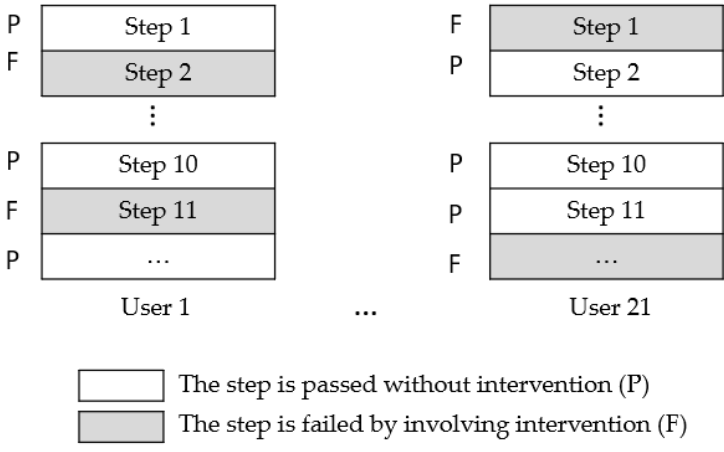
Figure 8. Step labeled with pass (P) and fail (F).